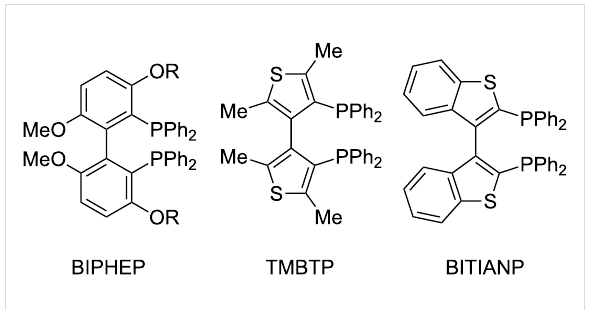
Figure 1: Chiral diphosphine ligands used for intermolecular asym- metric Heck